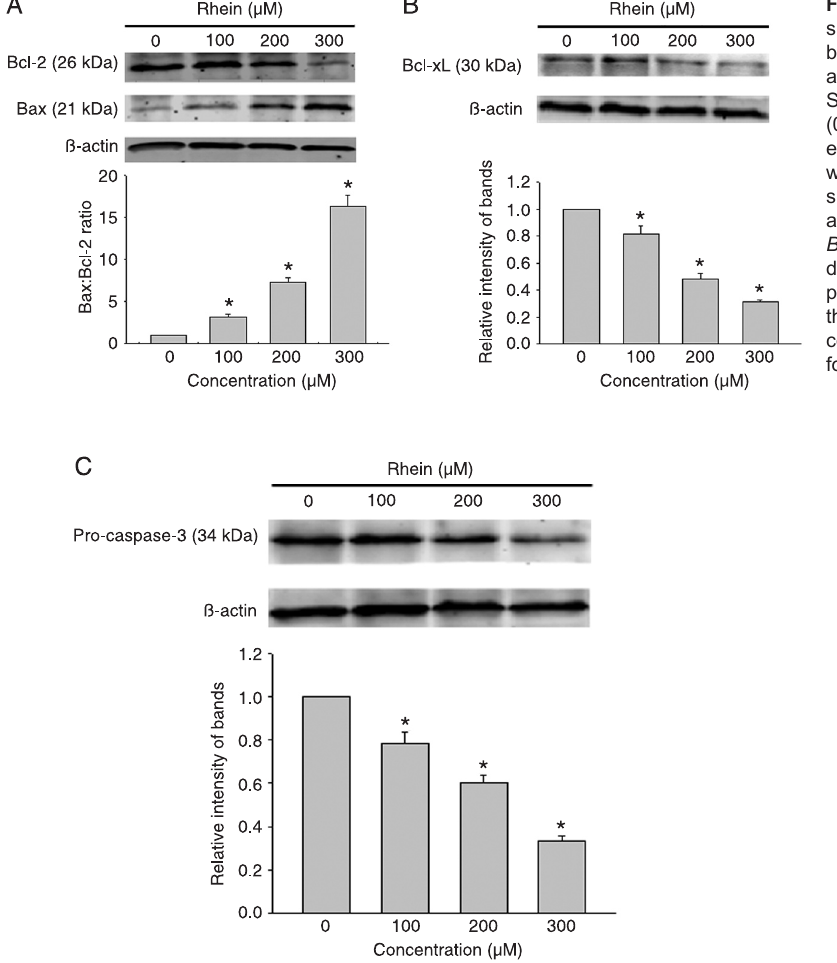
Figure 5. Rhein decreased the expres- sion of Bcl-2, Bcl-xL and